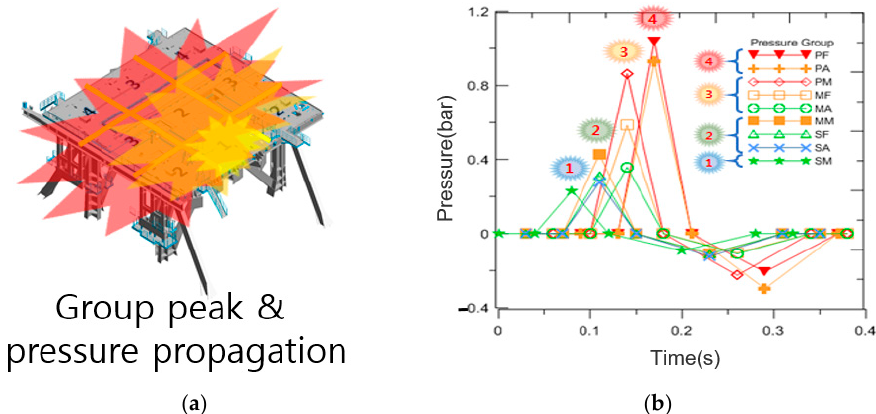
Figure 15. Proposed methodology for blast pressure application: group peak and propagation, ( a ) blast pressure application and ( b ) pressure configuration in time domain.